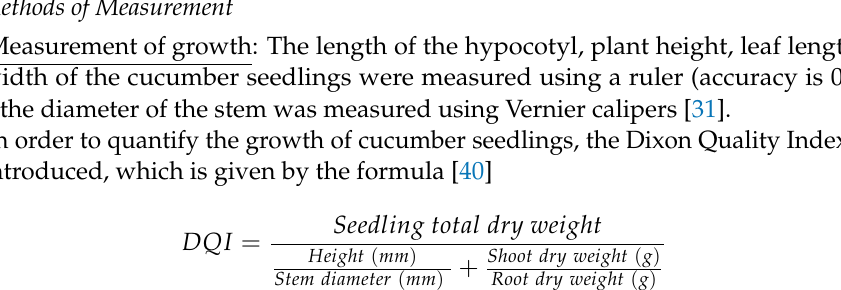
Figure 3. Light intensity distribution in cucumber seedling placement plane.